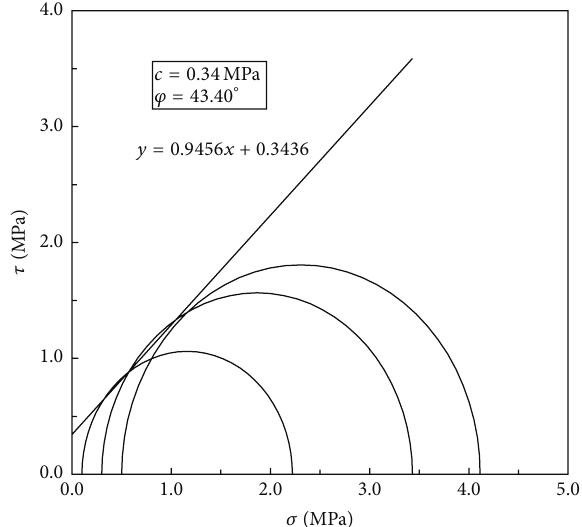
Figure5:Mohr’scirclesandstrengthenvelopeofsimulatedsoftrock